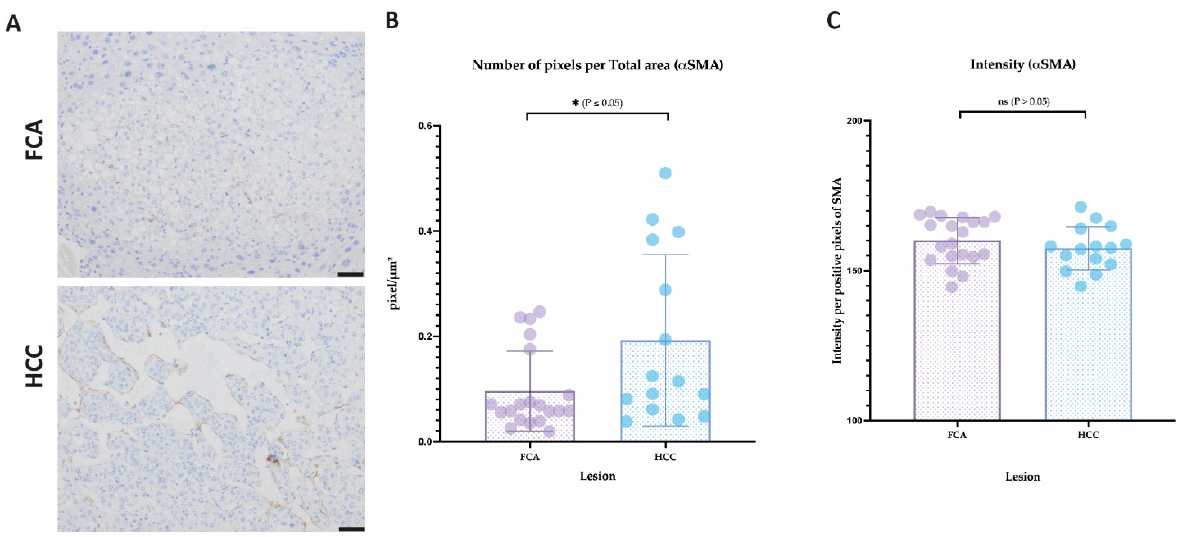
Figure 7. Analysis of vessels per lesion for expression of smooth muscle actin ( α -SMA). ( A ) Im- munostaining of α -SMA in FCA and HCC, ( B ) number of α -SMA positive pixel/total area and ( C ) intensity of α -SMA/positive pixel. for statistical significance, accepted p value: * p value ≤ 0.05. Scale bar: 50 µm (magnification 20×).